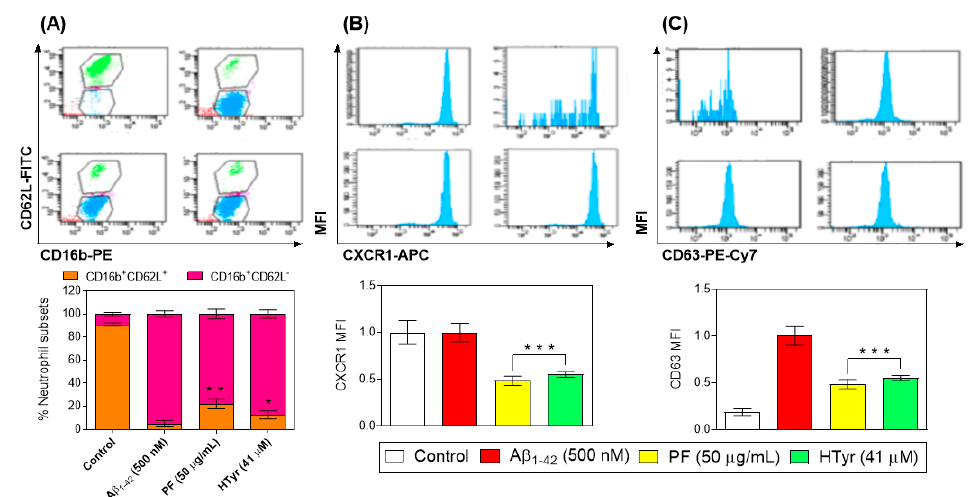
Figure 5. Membrane expression of ( A ) CD16b, ( B ) CXCR1, and ( C ) CD63 in A β 1-42 -stimulated primary human neutrophils treated with the PF from VOO (25 and 50 µ g/mL) or hydroxytyrosol (HTyr, 41 µ M) for 6 h. Values are means of the three independent experiments in triplicate, with their standard errors represented by vertical bars (* p < 0.05; ** p < 0.01; *** p < 0.001 vs. A β 1-42 -treated cells).